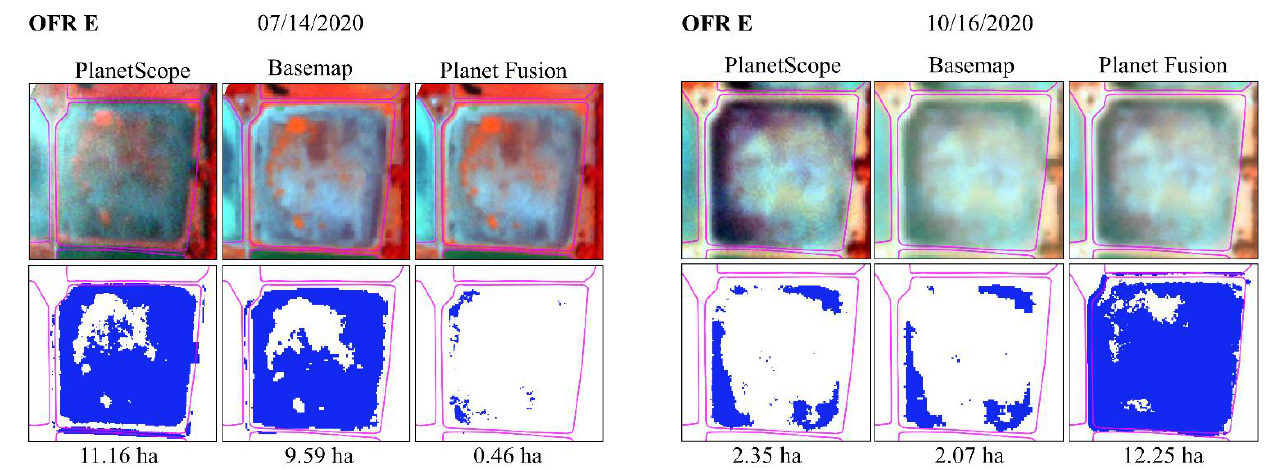
Figure 10. OFR E (see Table 2) PlanetScope, Basemap, and Planet Fusion false-color composites (blue: red, green: green, and red: NIR) and the surface water classification for 07/14/2020 and 10/16/2020.